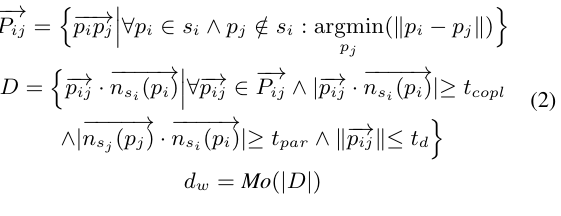
Figure 3: Width computation given s ∈ w (grey), with the sam- pled points ∀ p ∈ s (green), the normals rows) and the vectors (green